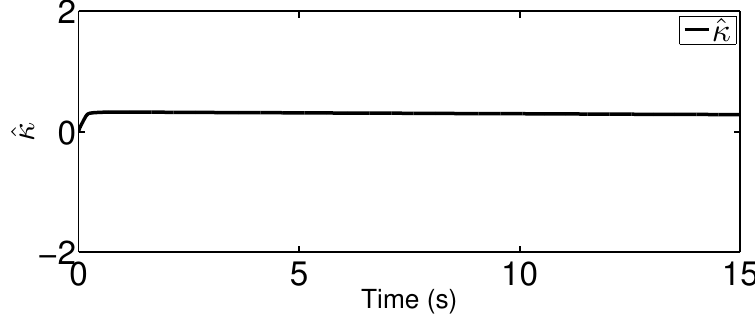
Figure 6. Trajectory of the estimation law ˆ κ .